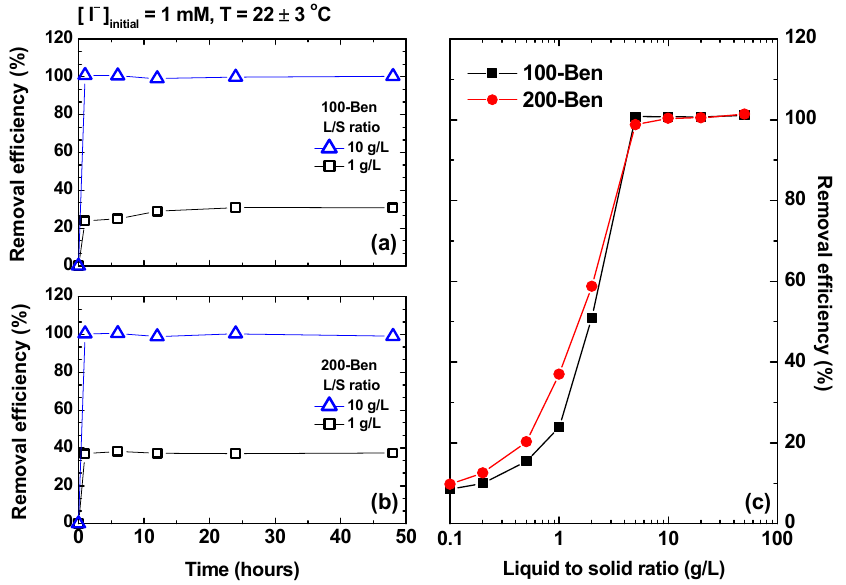
Figure 3. Iodide removal efficiency, determined at room temperature as a function of reaction time, for two different HDPy-modified bentonites, such as ( a ) 100-Ben and ( b ) 200-Ben; ( c ) iodide removal efficiencies obtained at various liquid-to-solid ratios, determined at reaction time of 24 h at room temperature. Initial aqueous iodide concentration was set to be 1 mM for all samples.